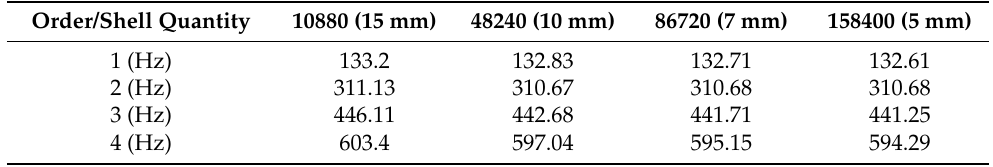
Figure 13. The first four-order vibration modes of the shell model, ( a ) 1st Order vibration modes, ( b ) 2nd Order vibration modes, ( c ) 3rd Order vibration modes and ( d ) 4th Order vibration modes. Meshes were generated for the shell structure via ANSYS ICEM by hexahedral ele- ment. Next, the inherent vibration frequency of this engine shell under different mesh quantities (mesh element size) was acquired, as seen in Table 5. It could be observed that the first four-order inherent frequencies of the engine shell were not sensitive to the mesh size, i.e., the result was basically stable when the mesh size was smaller than 10 mm. In this study, the mesh size was chosen as 10 mm in the modal calculation of this engine shell.